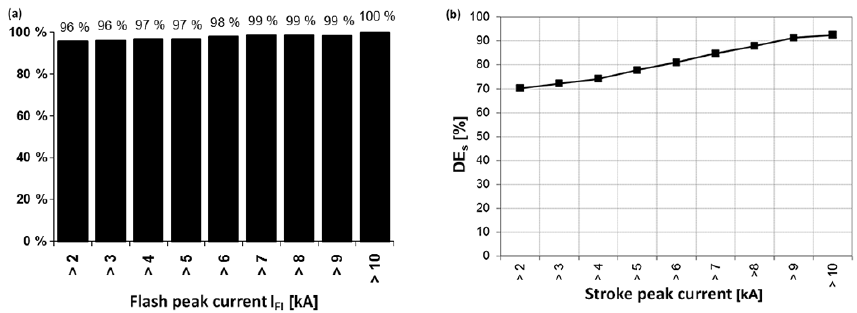
Figure 6. (a) Flash DE and (b) stroke DE determined for negative return strokes at the GBT (2005–2014).